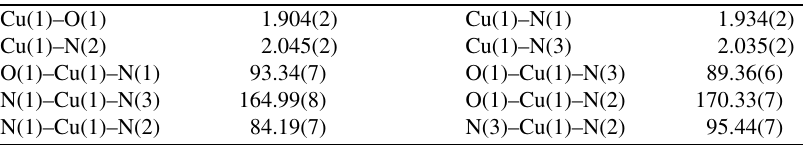
Table 2. Selected bond distances (Å) and angles (°) for the